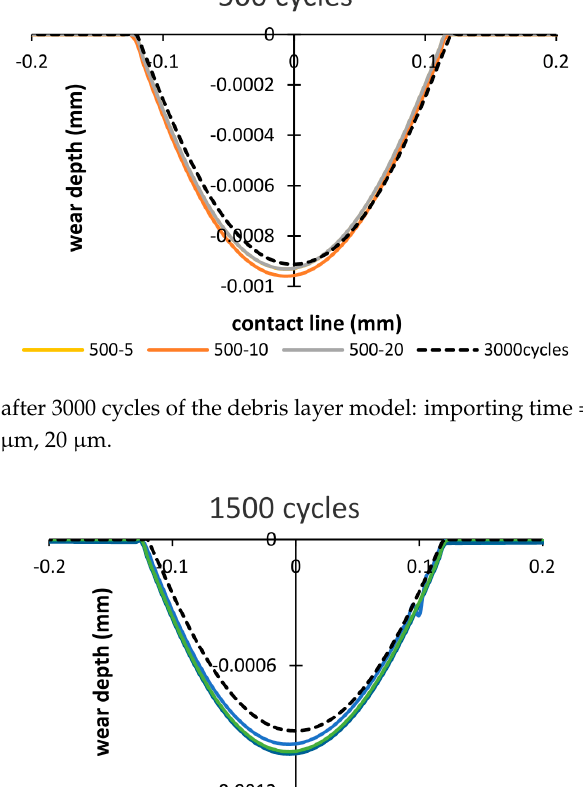
Figure 14. Wear scar after 3000 cycles of the debris layer model: importing time = 1500 cycles and layer thickness = 5 µm, 10 µm, 20 µm.